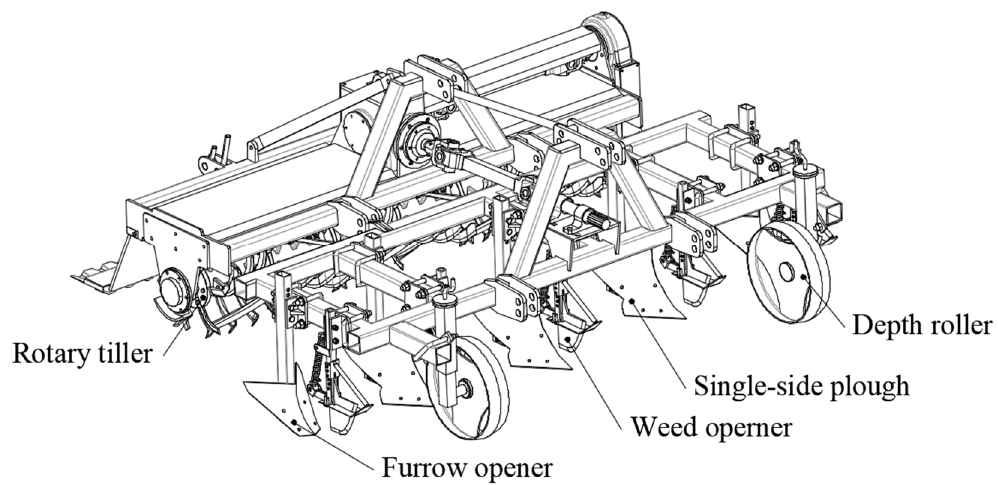
Figure 2. The schematic of the field experiment structure for CTSR.